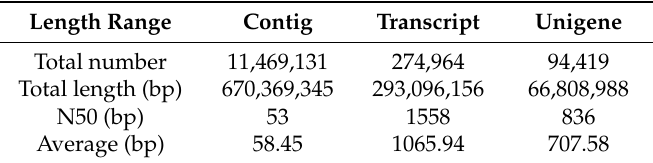
Figure 1. Length distribution of Trinity assembly for unigenes of Phelipanche aegyptiaca. Table 1. Assembly statistics for Phelipanche aegyptiaca